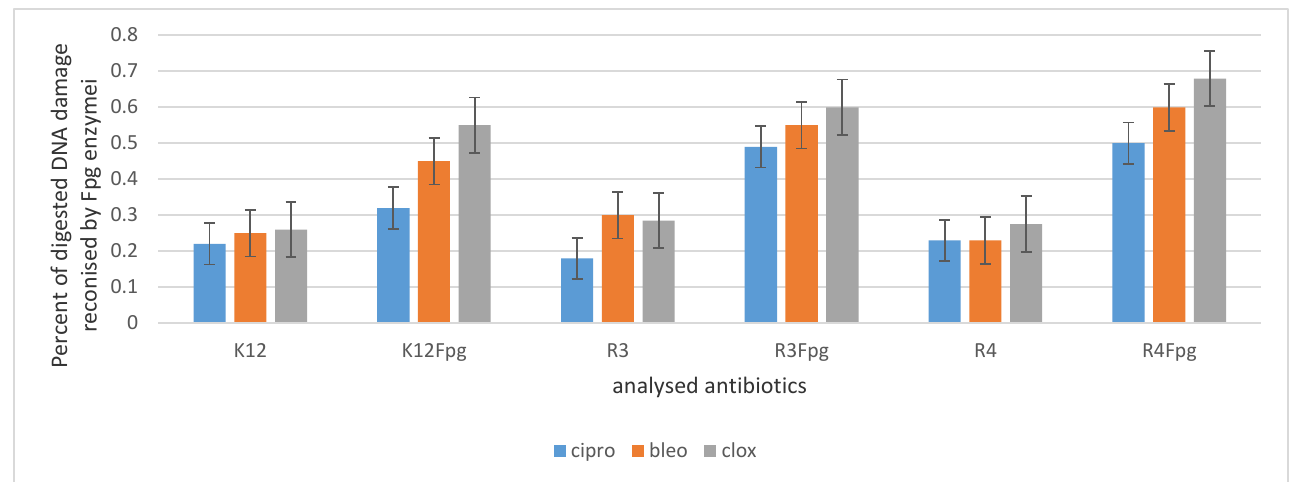
Figure 9. Percentage of bacterial DNA recognized by Fpg enzyme in model bacterial strains after ciprofloxacin, bleomycin, and cloxacillin treatment. The compounds were statistically significant at p < 0.05.